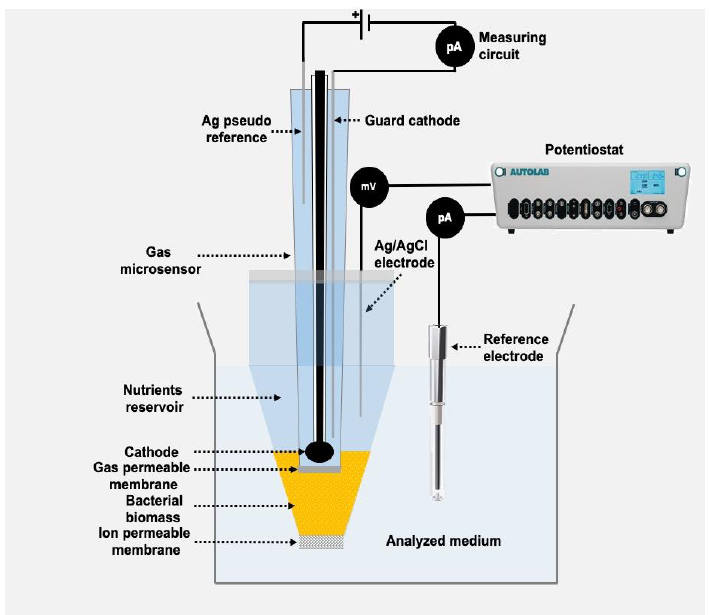
Figure 5. Schematic representation of the ESC technique where a potentiostat is used to assure a constant current between the Ag/AgCl electrode in the nutrient reservoir of the biosensor and an external reference. (Original image from authors).